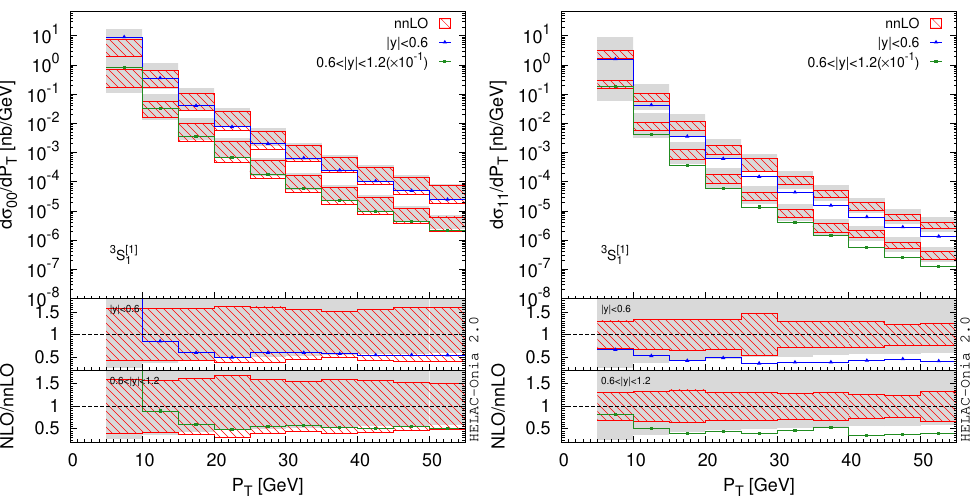
Figure 13 . Comparisons of spin-dependent differential cross sections for the Fock state 3 S [1] tween nnLO calculations and the complete NLO